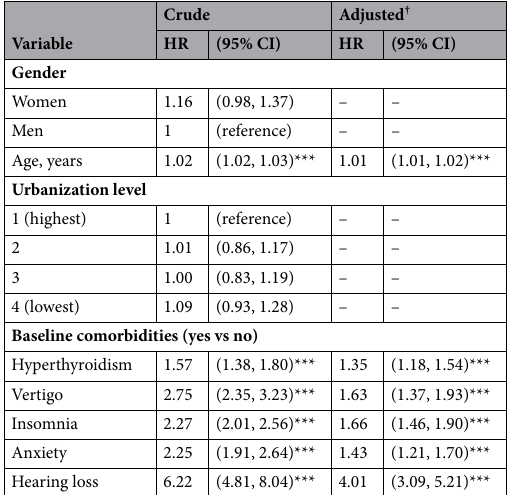
analysis illustrates that the cumulative incidence of tinnitus was significantly higher in the hypothyroidism cohort than in the non-hypothyroidism cohort (log-rank test, p < 0.001) (Fig. 1).